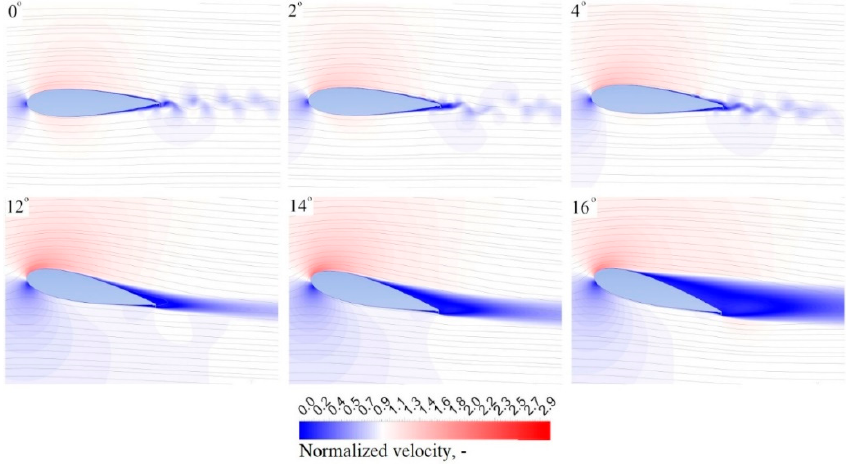
Figure 12. Normalized velocity contours for 0 ° , 2 ° , 4 ° and 12 ° , 14 ° , 16 ° angles of attack.